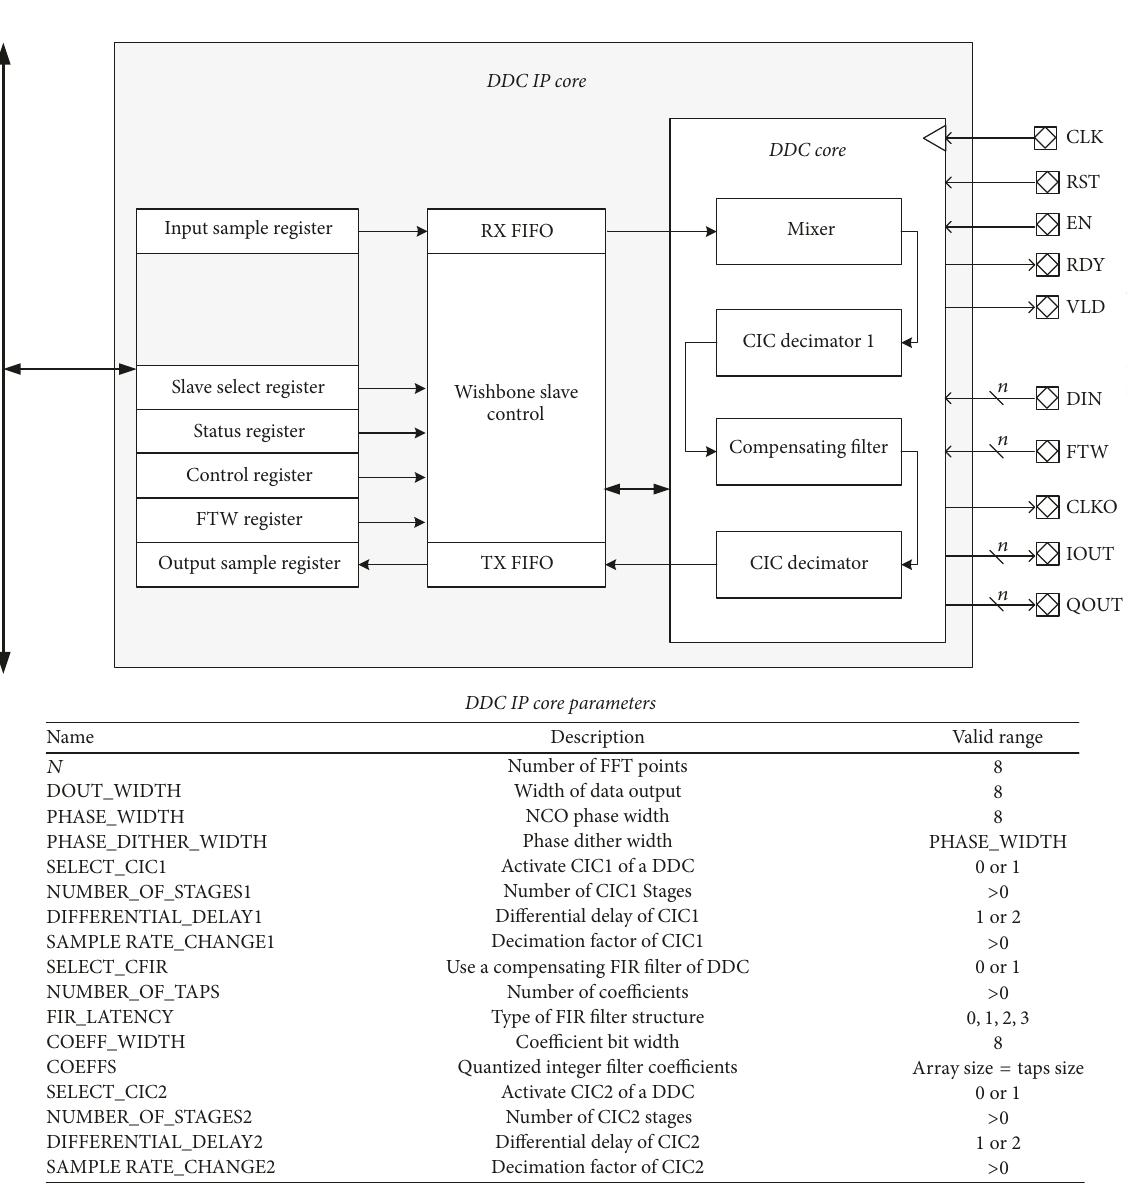
Figure 8: An architecture of the DDC IP